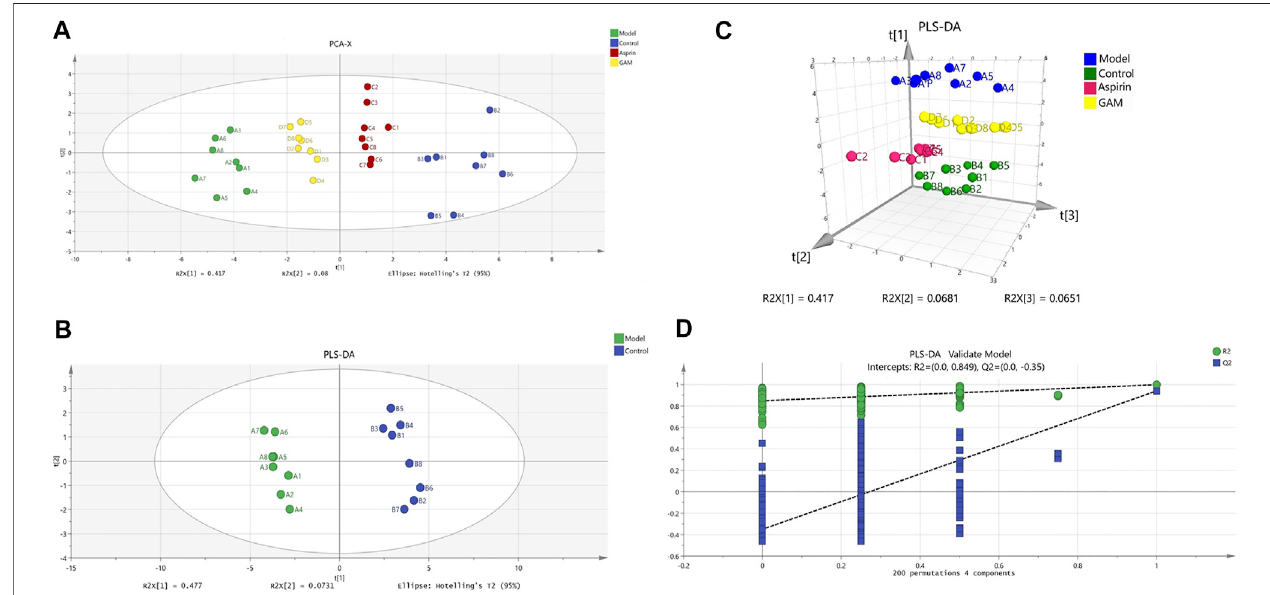
FIGURE3| Scoringchartand200permutationtests( n =8).PCAmodelofcontrol,model,aspirin,andmiddle-dosegallicacidgroup (A) ;PLS-DAmodelofcontrol and model group (B) ;Three-dimensional PLS-DA scoreplots ofcontrol, model, aspirin, and middle-dosegallic acidgroup (C) ; Cross-validationof thePLS-DAmodel of control and model group (using 200 random permutations) (D) .